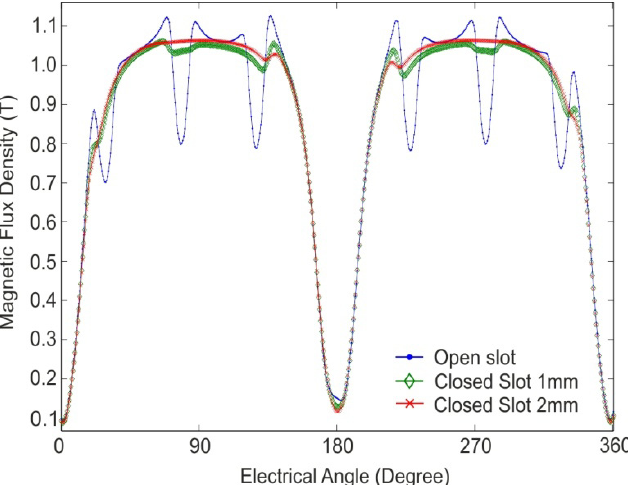
Figure 5. Magnitude of the magnetic flux density in the middle of the air-gap: for open slots (dot); closed slots 1 mm thick (diamond); and closed slots 2 mm thick (cross), simulated over two magnetic poles.